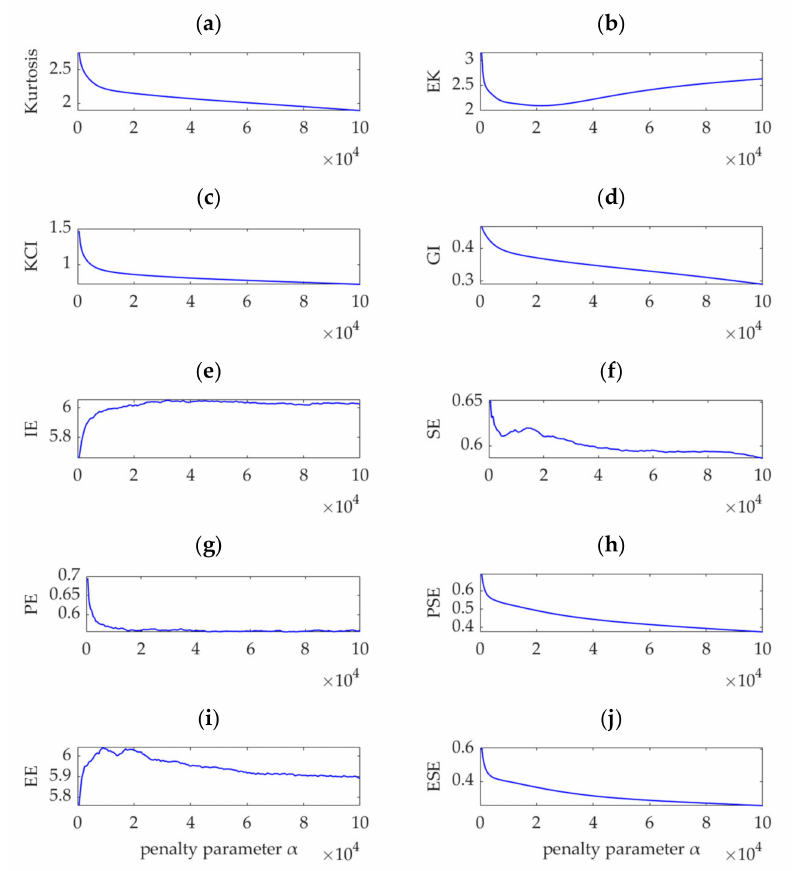
Figure 6. Relationship between different indices and penalty parameter α